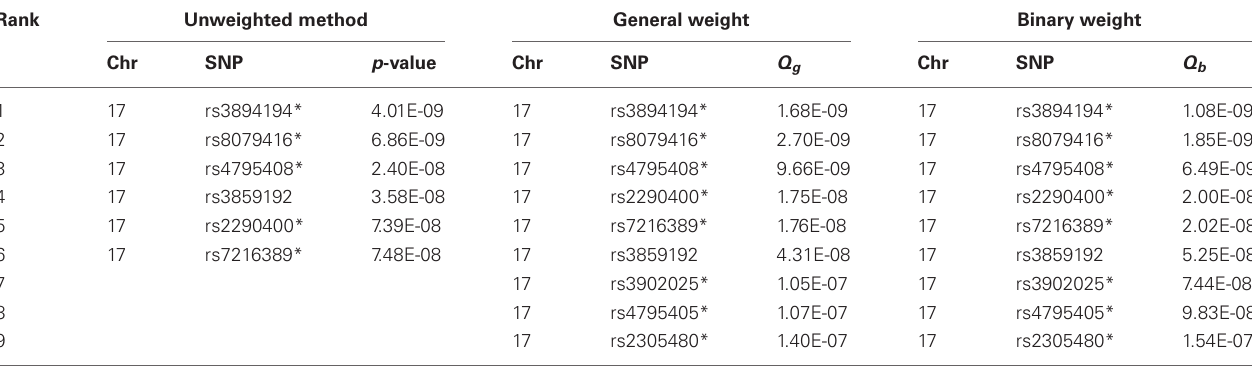
Table A2 | The significant SNPs identified by the unweighted method and the weighted methods (using general weight or binary weight) in the MAGICS analysis.